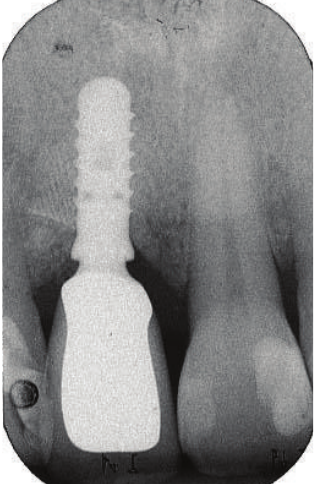
Figure 21: Periapical radiograph showing the definitive restoration seated in position.